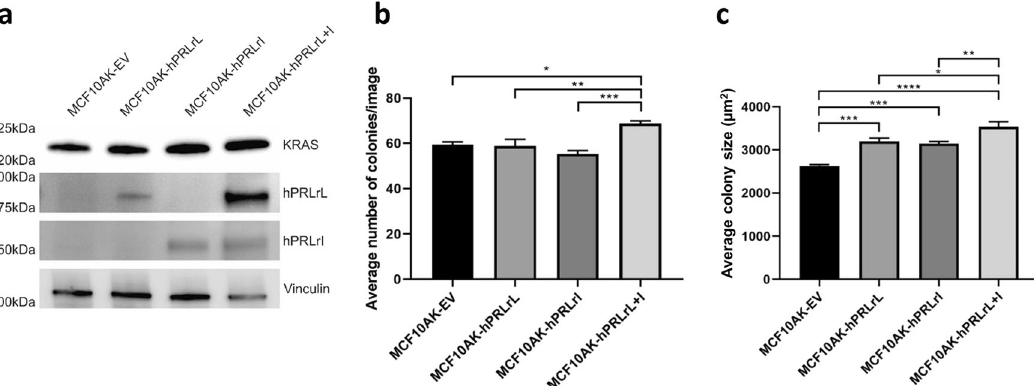
Fig. 6 KRAS-G12V over-expression alongside hPRLrL + I co-expression in vitro. a MCF10A hPRLr over-expression transfectants received an additional stable transfection of KRAS-G12V, and expression was con fi rmed via IB. Cells were then grown in soft agar, and both b colony number and c colony size were determined. * p < 0.05, ** p < 0.01, *** p < 0.005, **** p < 0.001. n = 3. Data is shown as mean ±